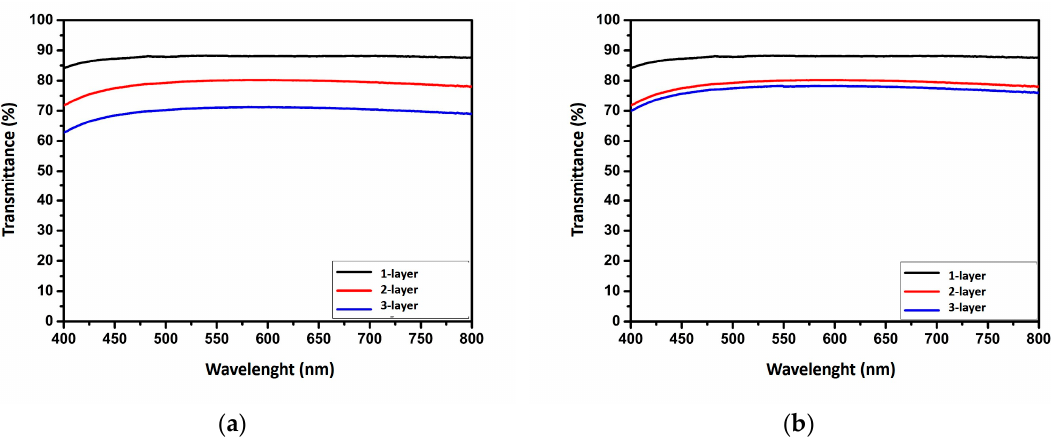
Figure 4. Optical transmittance of LBL assembled AgNW films for ( a ) 3 h and ( b ) 12 h deposition times.